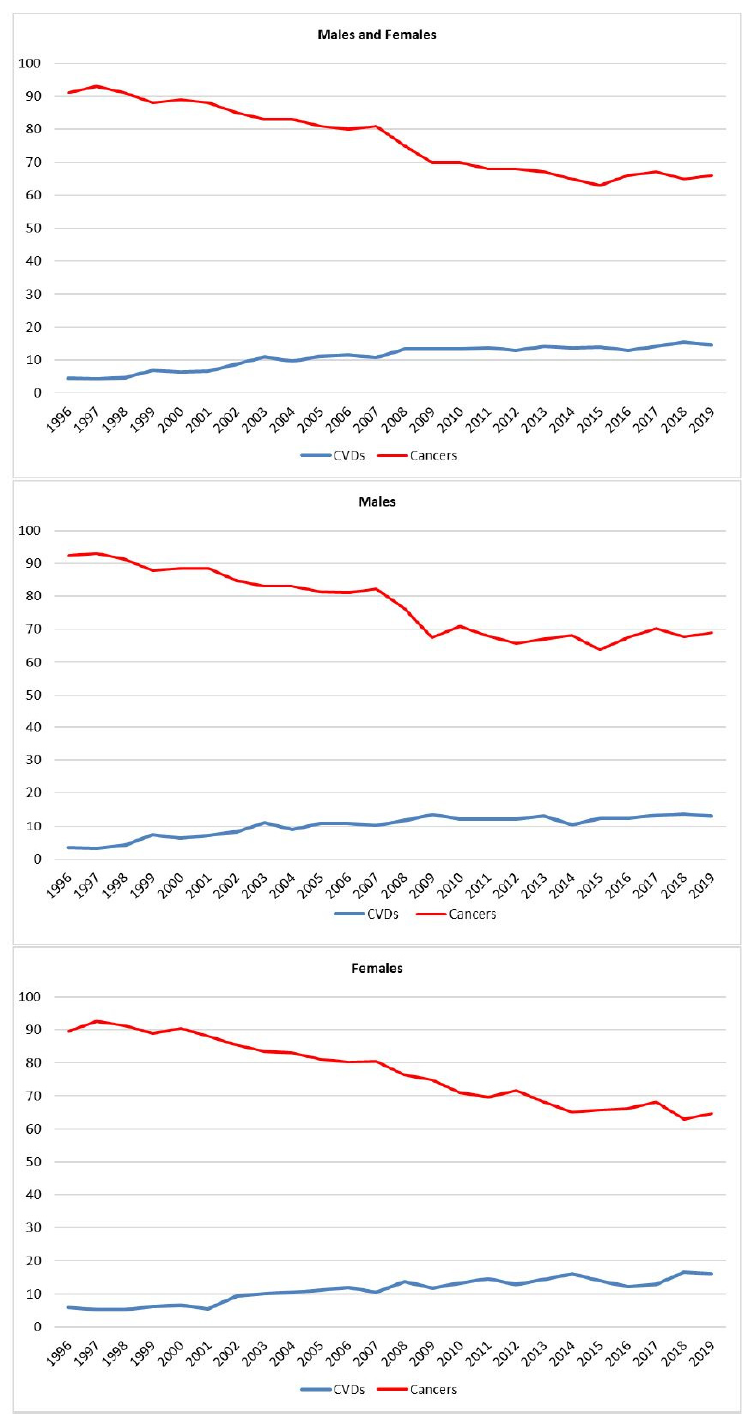
Figure 2. Percentage analysis of causes of death in cancer survivors diagnosed from 1996 by year of death and sex, Reggio Emilia, Italy. 1996–2019. Percentages were calculated on deaths that had occurred in the year among can-cer patients diagnosed from 1996, i.e., deaths in 1996 only include fatalities that oc-curred in patients diagnosed in 1996, while deaths that occurred in 2019 include fatali-ties in cancer survivors diagnosed from 1996 to